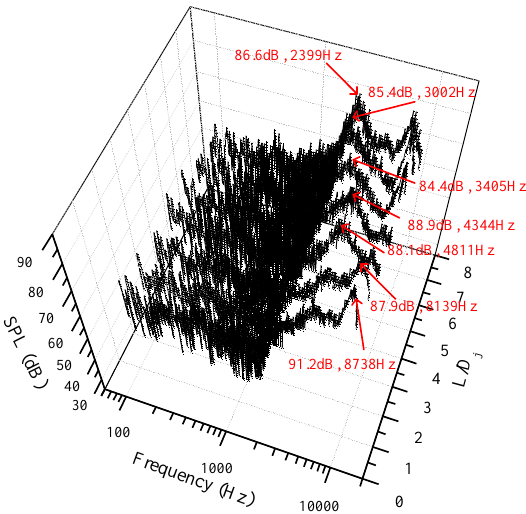
Figure 5. Acoustic spectrograms of Hartmann Resonance Tube (HRT) at nozzle pressure ratio (NPR) = 6 for L / D j ranging 1–7.